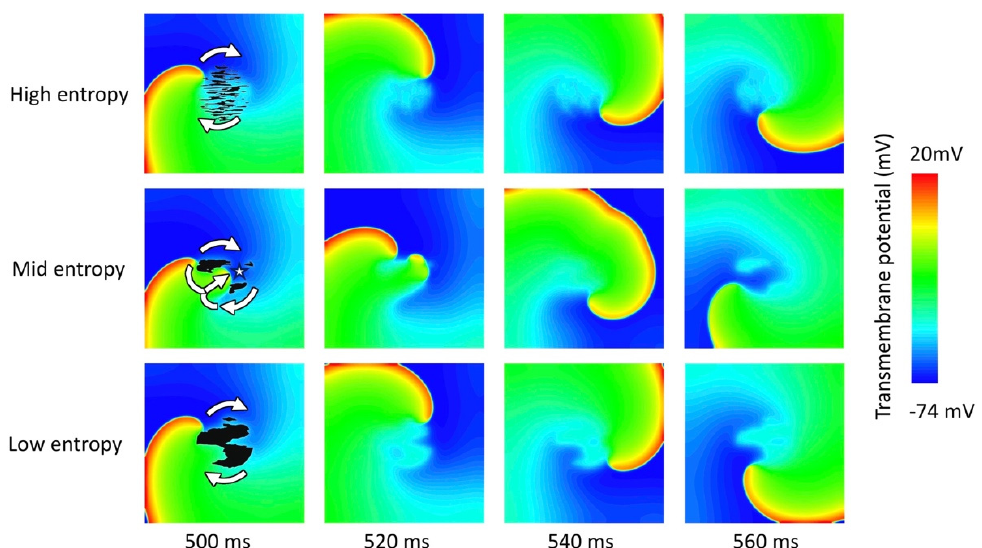
Figure 6. Snapshots of the transmembrane potential at different time instances for three different fibrosis patterns with 20% myofibroblast density (black areas in the left column represent myofibroblasts). White arrows indicate the reentry trajectory, and the white star shows the exit point of the reentry. Reentrant activity was initiated by a cross-field stimulus. The top row shows the reentry around the fibrotic region of high entropy that resembles interstitial fibrosis. The middle row shows the reentrant activity with an exit point due to the separation of the clusters with a mean entropy value that resembles disperse patchy fibrosis. The bottom row shows reentrant activity around an area of low entropy that resembles a pattern of patchy fibrosis.